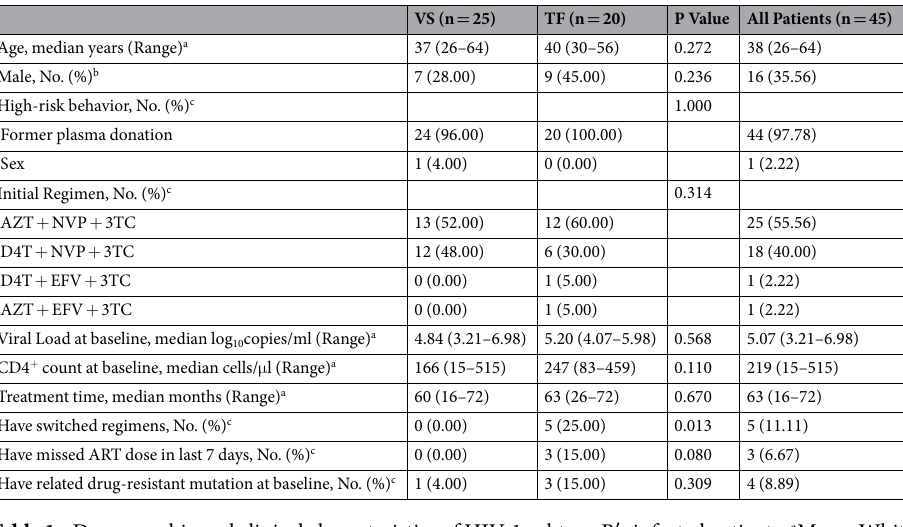
Table 1. Demographic and clinical characteristics of HIV-1 subtype B ′ - infected patients. a Mann-Whitney Test; b Chi-Square Test; c Fisher’s Exact Test; Abbreviations: 3TC, lamivudine; AZT, zidovudine; d4T, stavudine; EFV, efavirenz; NVP,